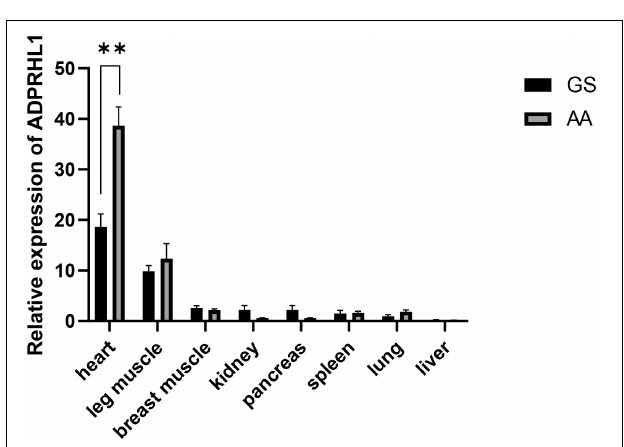
DNA from each individual was subjected to indel identification and genotype analysis using ADPRHL1